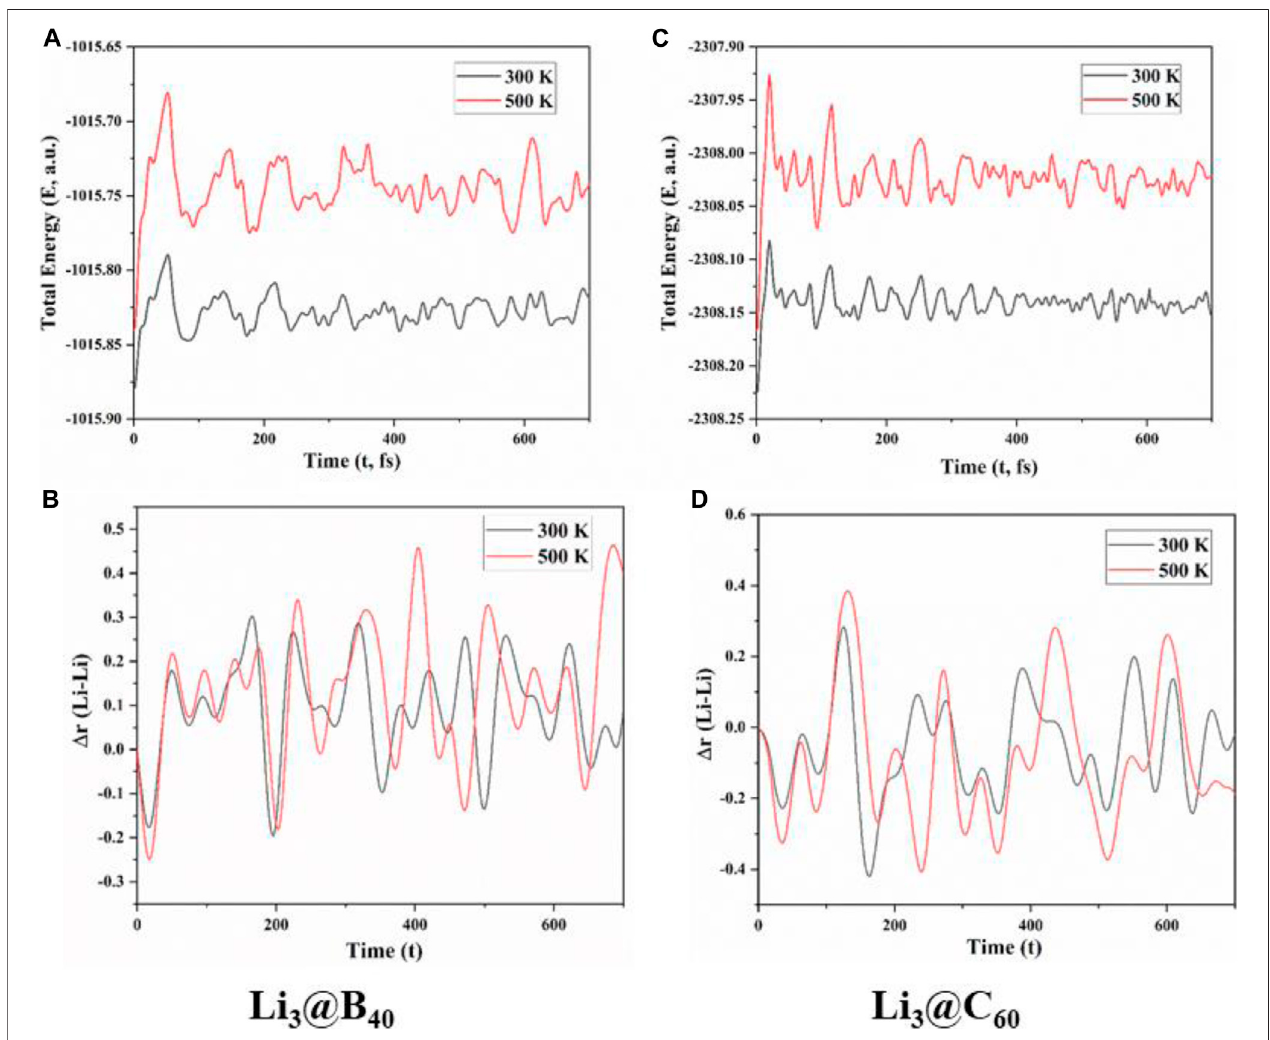
FIGURE 3 | (A) and (C) Time evolution of total energy for Li 3 @B 40 and Li 3 @C 60 systems, respectively, (B) and (D) change in the Li-Li bond lengths with respect to the corresponding optimized value (at t (cid:3) 0) against time for Li 3 @B 40 and Li 3 @C 60 systems, respectively.